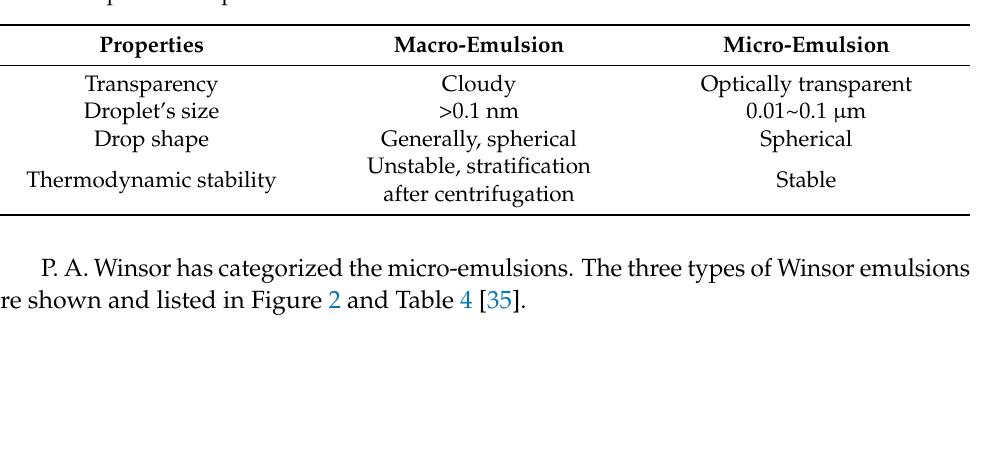
Table 3. Properties comparison between macro-emulsion and